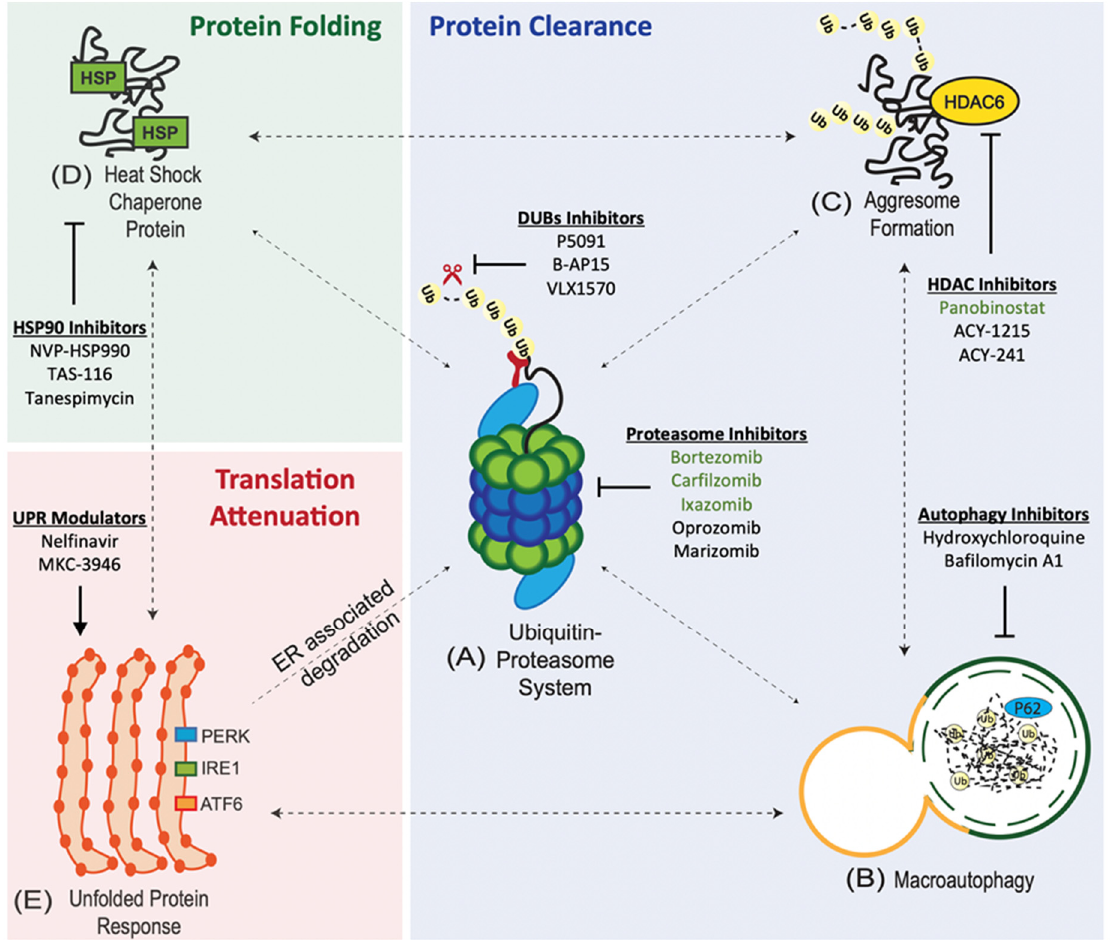
Figure 1. Protein handling pathways in cancer cells. cancer cells have to cope with a large burden of misfolded proteins, which if not managed appropriately results in endoplasmic reticulum (ER) stress and eventual cell death. As such, cancer cells are highly dependent on a tightly regulated network of protein quality control pathways such as ( A ) the ubiquitin proteasome system (UPS), ( B ) macroautophagy, ( C ) aggresome formation, ( D ) heat shock response, and ( E ) the unfolded protein response.